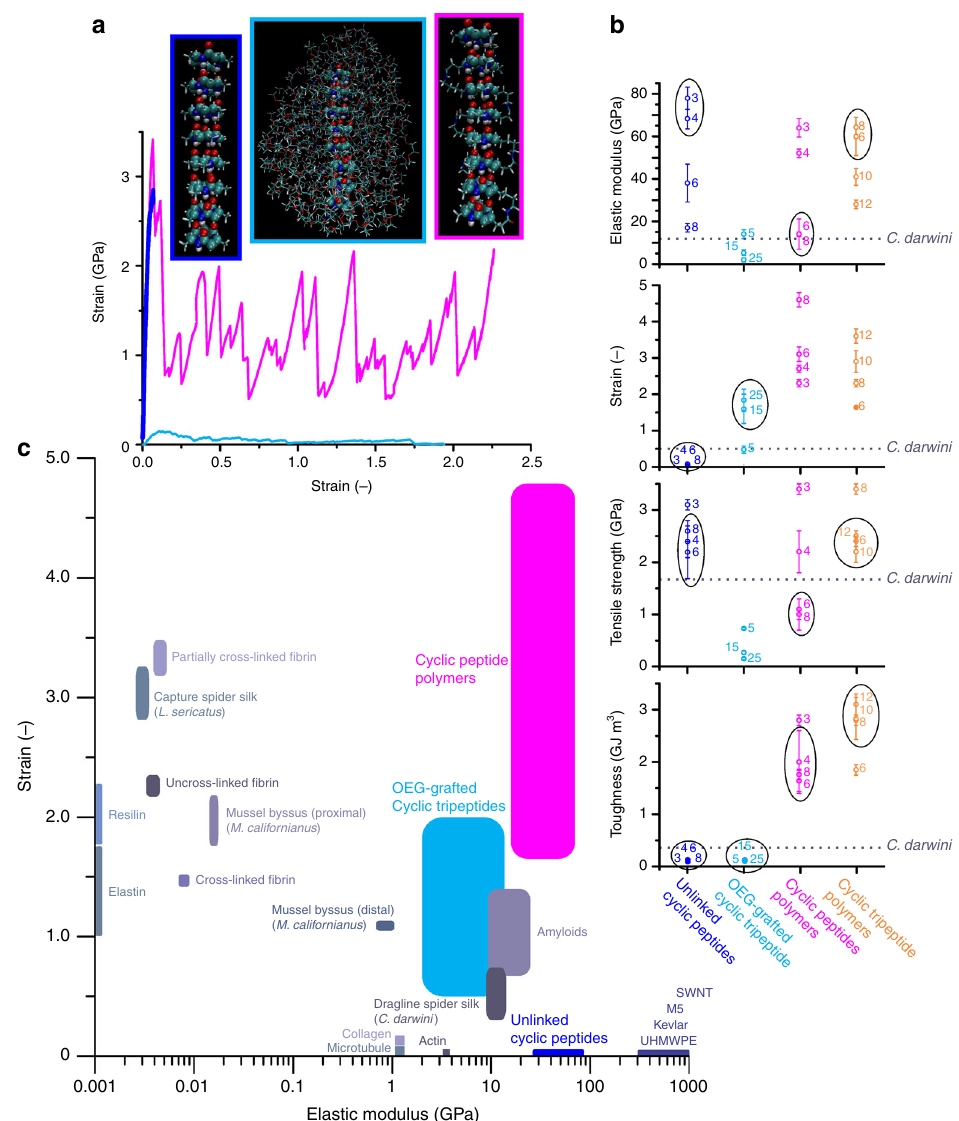
Fig. 1 Molecular dynamics simulations of cyclic peptide assemblies. a Representative stress-strain curves of unlinked ( cyclo [(- β -Ala) 3 -]; blue), OEG-grafted ((CH 2 CH 2 O) 25 CH 3 ; cyan), and polymerized ( cyclo [(- β -HLys- β -Ala- β -HLys)-] + cyclo [(- β -HGlu- β -Ala- β -HGlu)-]; magenta) assemblies consisting of eight subunits. In MD simulations, α -carbon atoms in the backbone of the bottom rings are held fi xed, while a spring with a spring constant of 5000 kJ mol − 1 is attached to the center of mass of the top ring and pulled upward along the fi bril axis at a constant velocity of 5 × 10 − 5 nm ps − 1 . b Computed elastic moduli, strain to failures, tensile strengths, and toughness values for the various cyclic peptide based assemblies (mean ± standard deviation (SD); N = 3). Dotted lines denote the reported values of dragline spider silk from C. darwini 8 . Numbers next to data points indicate the number of amino acids in each subunit (blue and magenta), number of OEG repeating units (cyan), or number of atoms in the linkage between subunits (orange). Circles denote data pairings that are not statistically different based on unpaired t tests ( p < 0.05). c Computed elastic moduli and strain to failures of cyclic β -peptide assemblies, in comparison with reported values for natural and synthetic materials 4,8, 9,17, 34,54 – 60 . Single-walled carbon nanotubes are abbreviated as SWNT, and